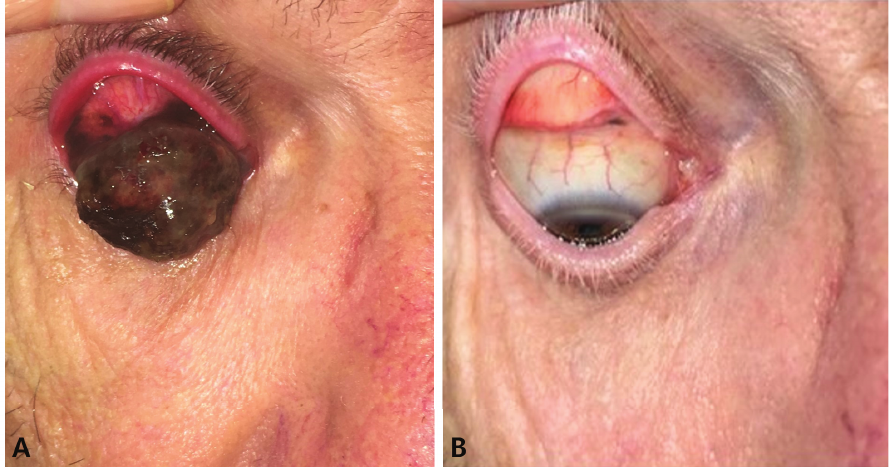
Figure 2. (A–B) A 66-year-old man with large invasive melanoma of bulbar and tarsal conjunctiva (A) presented to Moorfields London was found to have invasive melanoma with lung metastasis. He was treated with a combination of ipilimumab and nivolumab at Moorfields Eye Hospital for six cycles of therapy over five months. Both the eye lesion and the lung metastases responded to the treatment (B). Reprinted from: Hong BY, Ford JR, Glitza IC, Cabala CAT, Tetzlaff M, Prieto VG, et al. Immune checkpoint inhibitor therapy as an eye-preserving treatment for locally advanced conjunctival melanoma. Ophthalmic Plast Reconstr Surg 2021;37:e9-e13. [21] Copyright (2021) by Lippincott Williams &